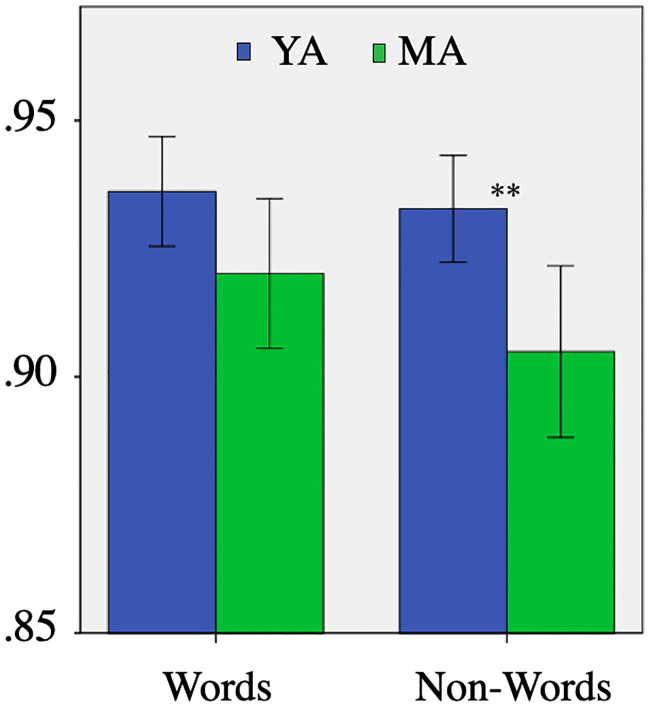
Correctly recognized syllables in Ws and NWs (**: s < .01).